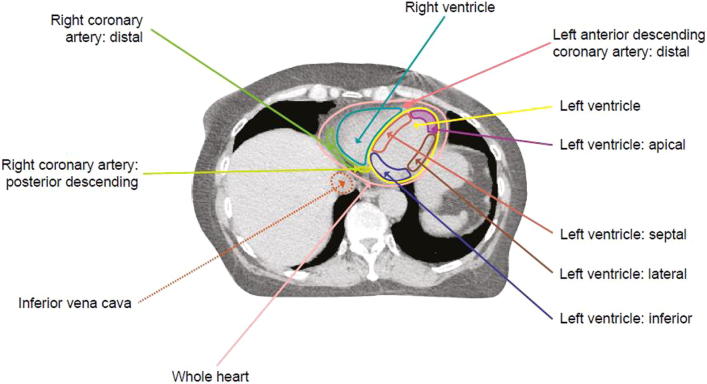
Axial radiotherapy CT planning image at the level of the left ventricle inferiorly showing contouring of the coronary arterial and left ventricular myocardial segments. See Supplementary Figs. 1–3 for further images.